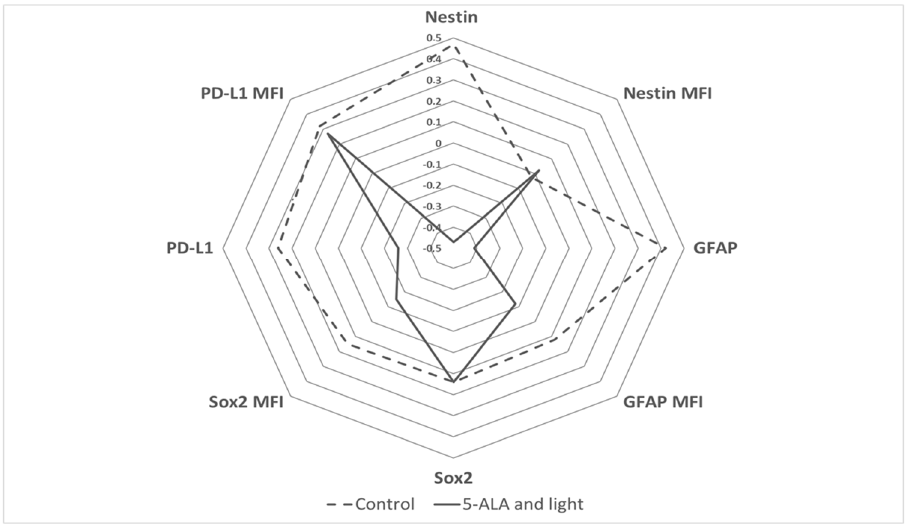
Figure 8. Radar plot summarizing the previous results of the observed percentages of Nestin, GFAP, PD-L1, and Sox2-positive GB-MSCs and the mean fluorescence intensity (MFI) of expression of Nestin, GFAP, PD-L1, and Sox2 markers at single cellular levels in GB-MSCs. Features’ values are mean-centered and divided by one standard deviation for better visual generalization. The punctured line depicts the feature values among control GB-MSCs, and the bold line depicts GB-MSCs exposed to 5-ALA and light. The radar plot demonstrates the decreased percentages of Nestin, GFAP, and PD-L1 expression by GB-MSCs treated with 5-ALA and light and the lack of change in the Nestin, GFAP, and PD-L1 MFI, with no alteration in the percentage and MFI of Sox2